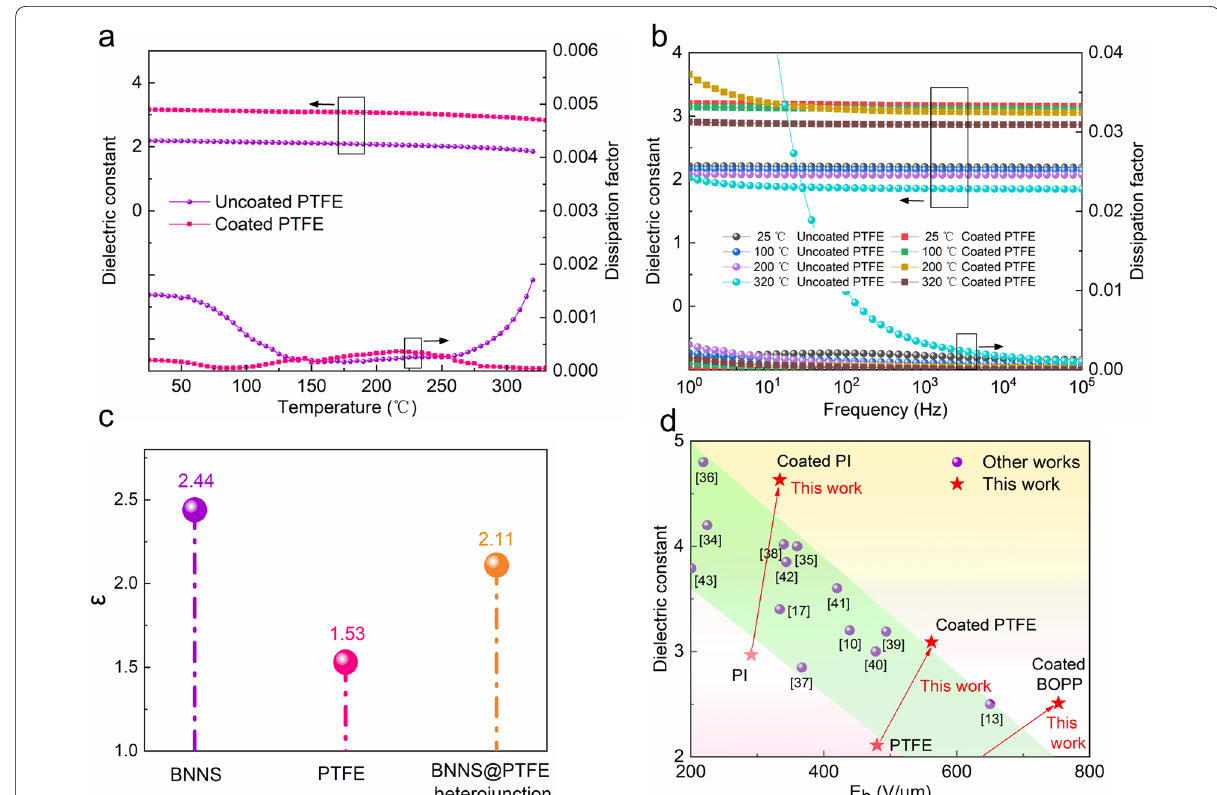
Fig. 4 Dielectric performance test and DFT calculation. a Changes in the K and DF values of PTFE with temperature (frequency of 10. 4 Hz) before and after coating. b Changes in the K and DF values of PTFE with frequency at different temperatures before and after coating. c The average static dielectric constant of the (001) surface of BN, the (001) surface of PTFE, and the BNNS@PTFE heterojunction calculated by the DPFT method. d The breakdown strength and dielectric constant of polymer dielectrics analyzed in the present study and reported in the literature at high temperature (150